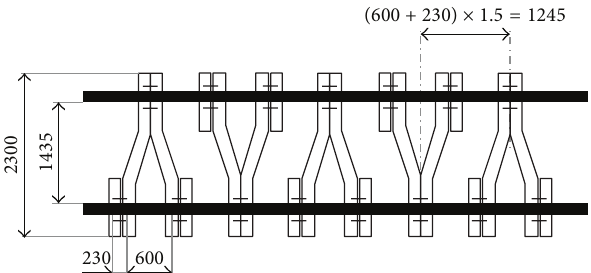
Figure 12: Track “Y-shaped” sleepers spacing as visible above.